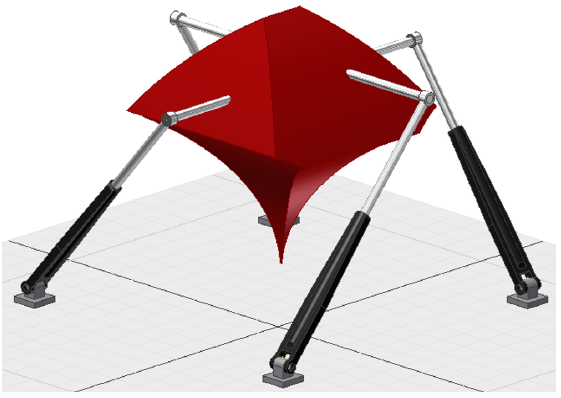
Figure 2. Workspace of the robot for y ≥